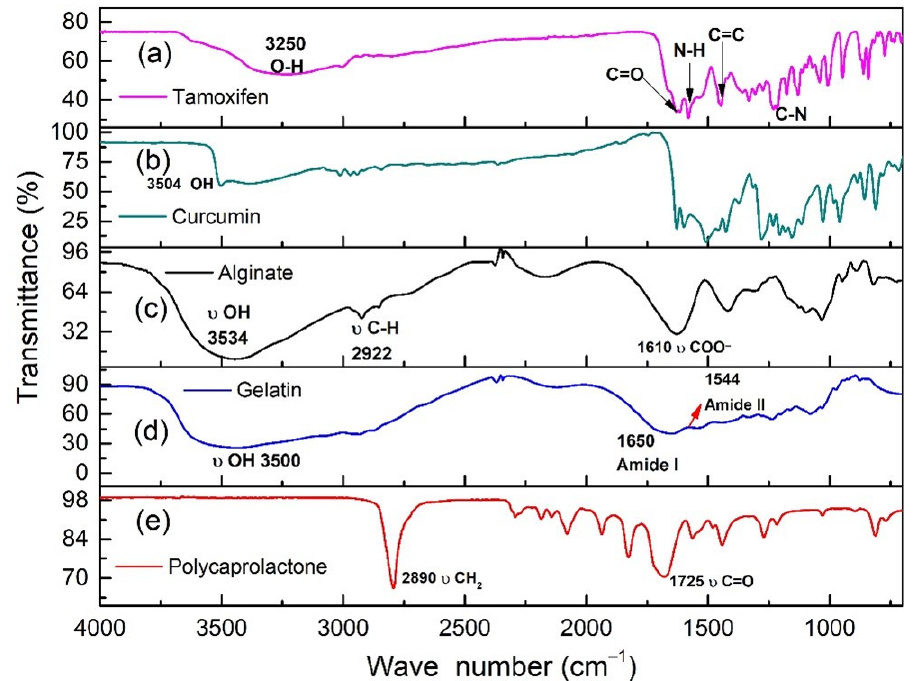
Figure 2. FTIR spectra of the materials used in the fabrication of the nanofibers. ( a ) TMX ( b ) curcu- min ( c ) alginate ( d ) gelatine and ( e ) polycaprolactone . ( c ) alginate ( d ) gelatine and ( e )